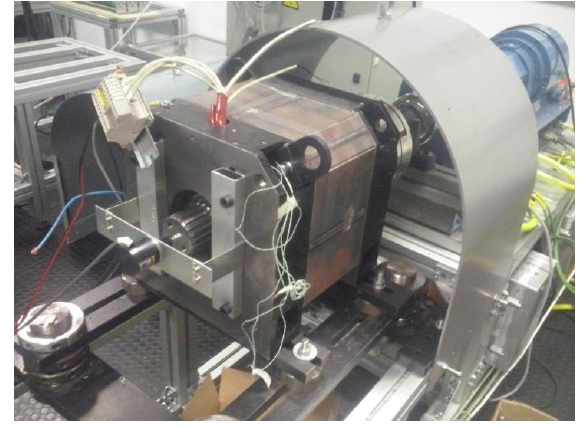
Figure 6. Experimental setup for a prototype